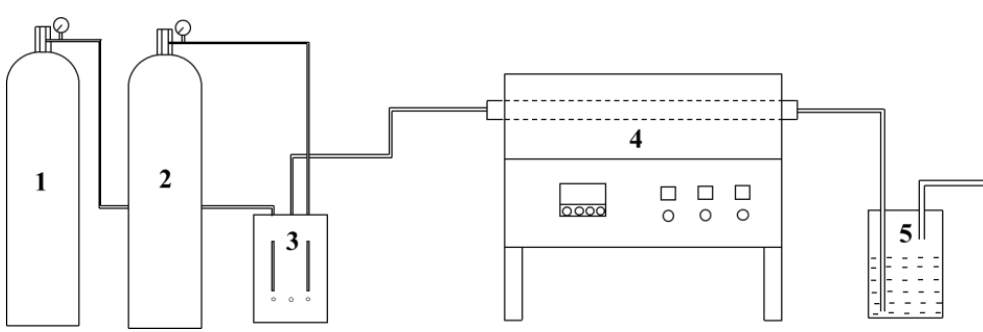
Figure 2. Schematic diagram of the roasting experimental setup (1. Oxygen cylinder. 2. Argon cylinder. 3. Gas mixing instrument. 4. Tube furnace. 5. Gas recovery device).